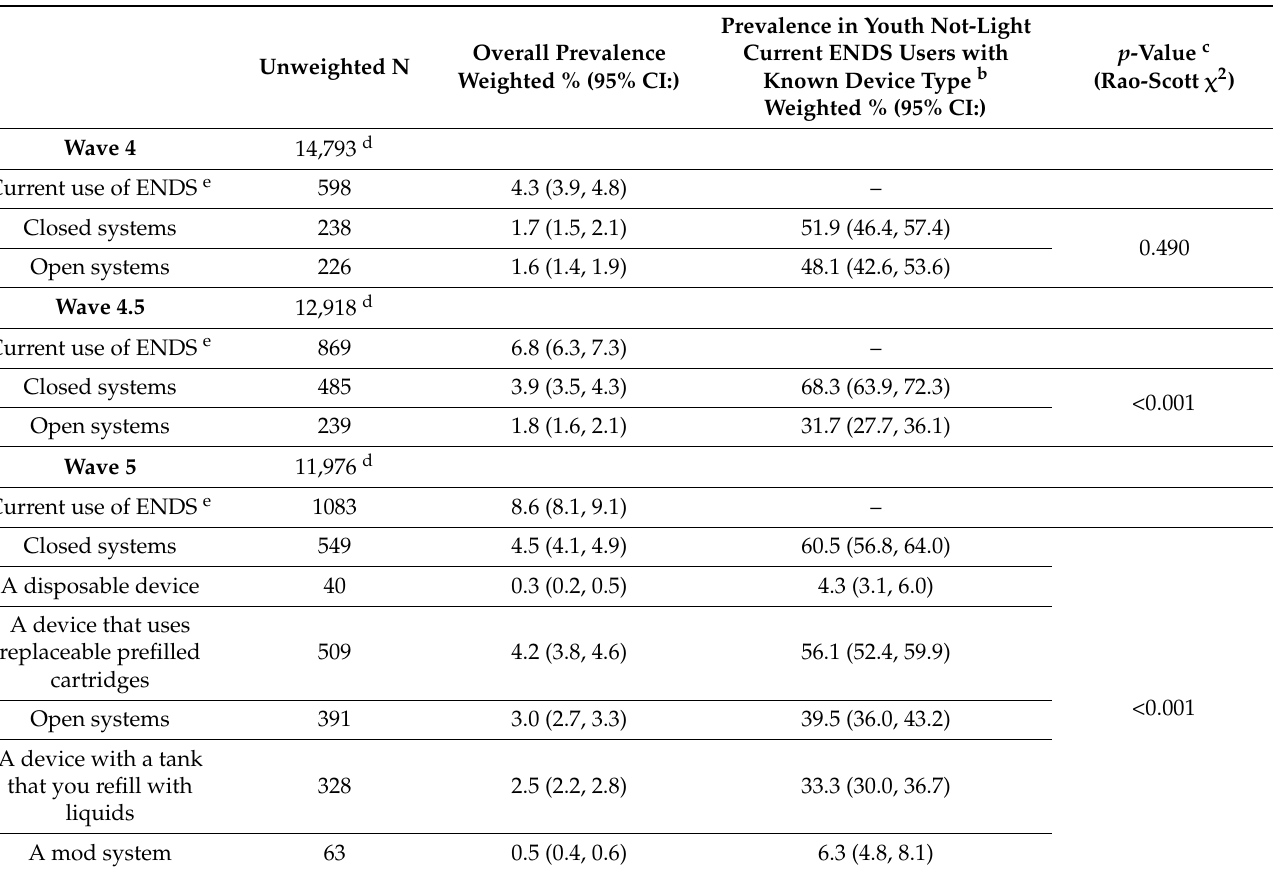
Table 1. Prevalence of youth current ENDS use, overall and by device type, PATH Study Waves